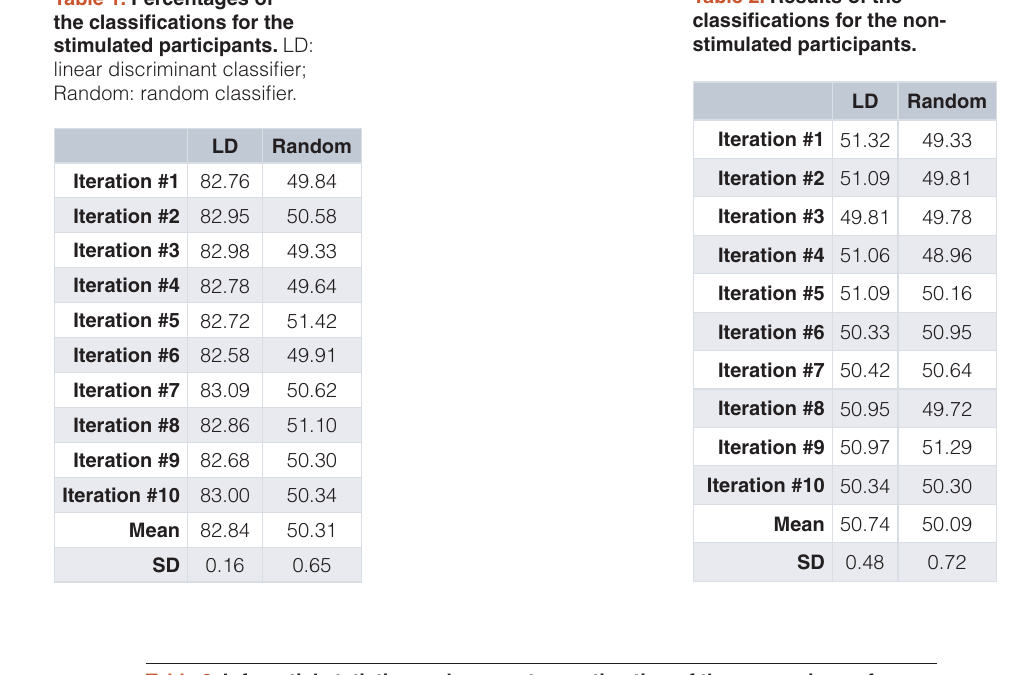
Table 3. Inferential statistics and parameters estimation of the comparison of the percentage of correct classification of the periods of stimulation and non- stimulation between the linear discriminant and the random